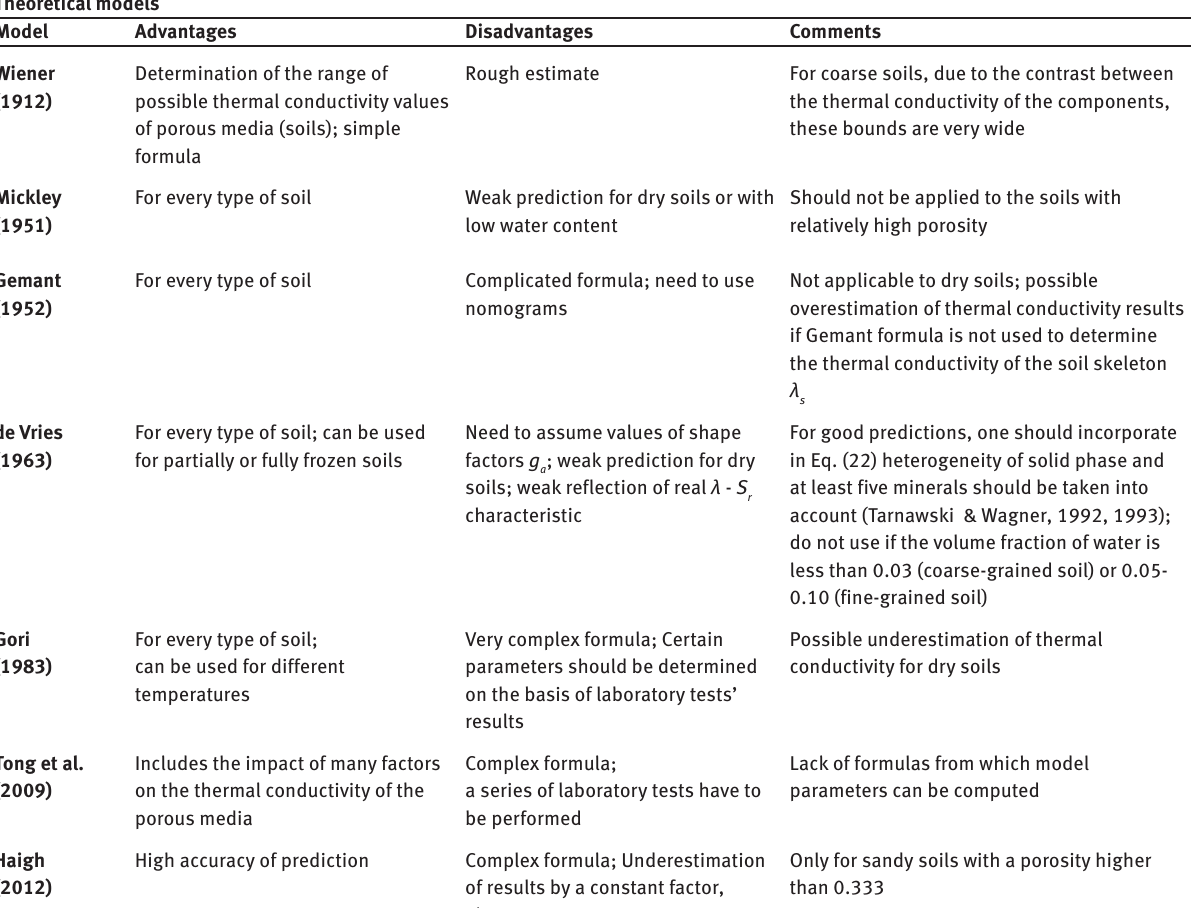
Table 3: Advantages, disadvantages and comments on the considered theoretical models (Różański, 2018). Theoretical